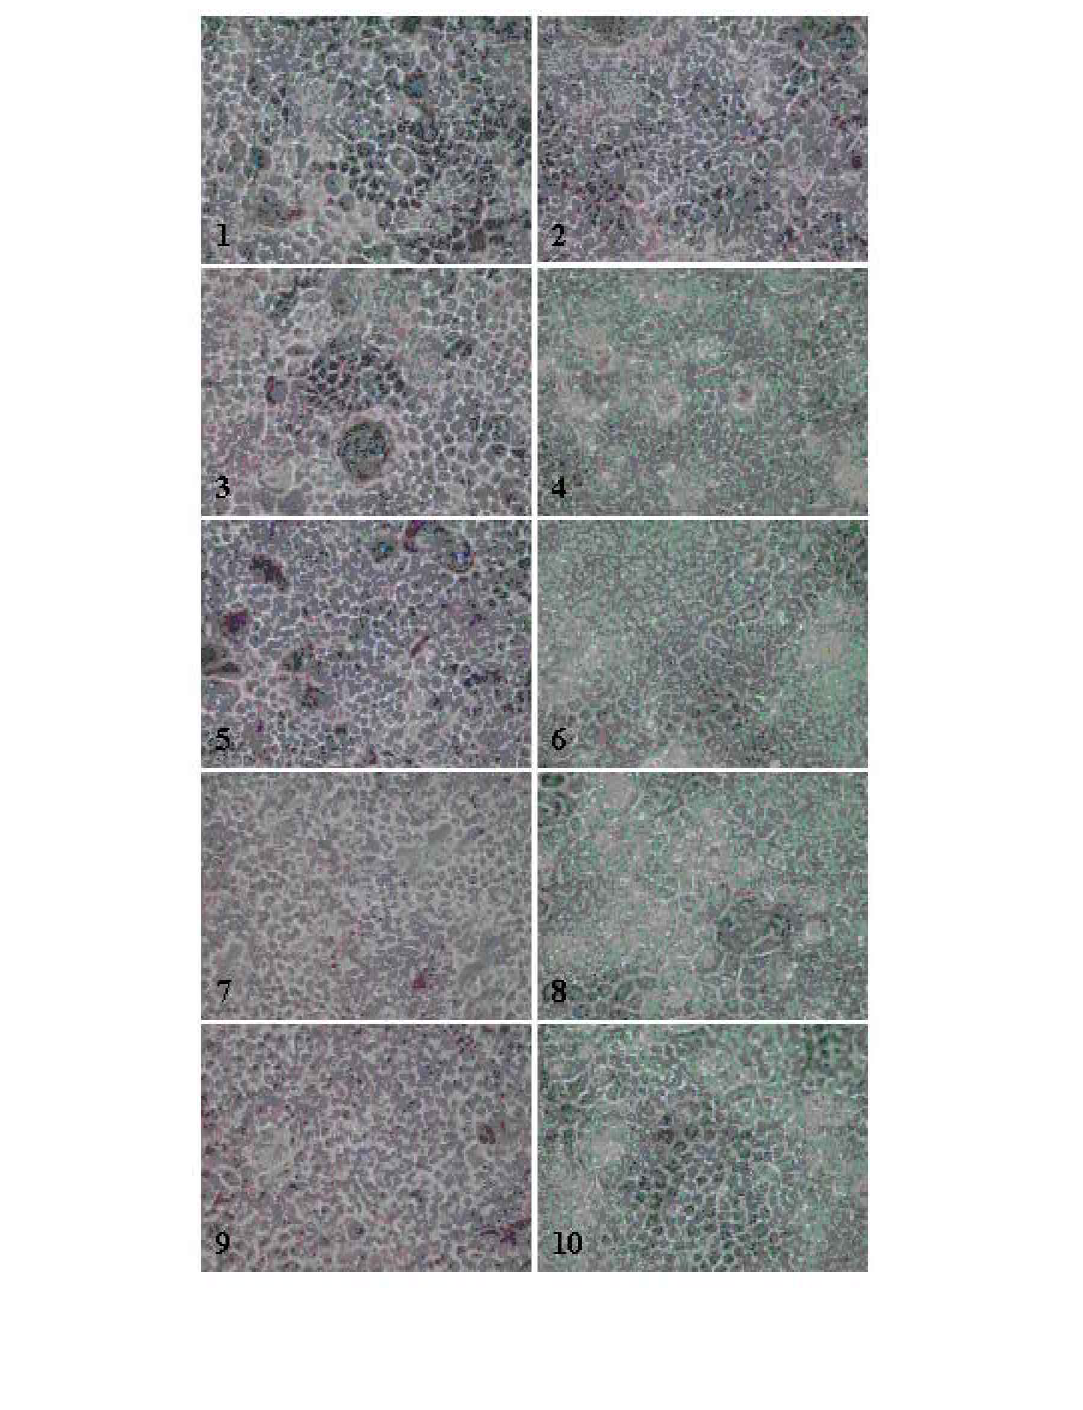
Fig. 5 Caco-2 cells stained with MTT, after incubation for 30 min with 1 mM of various epicatechins. 1, Control; 2, Cu (II); 3, EC; 4, EC+Cu (II); 5, ECg; 6, ECg+Cu (II); 7, EGC; 8, EGC+Cu (II); 9, EGCg; 10, EGCg+Cu (II); magni› cation x